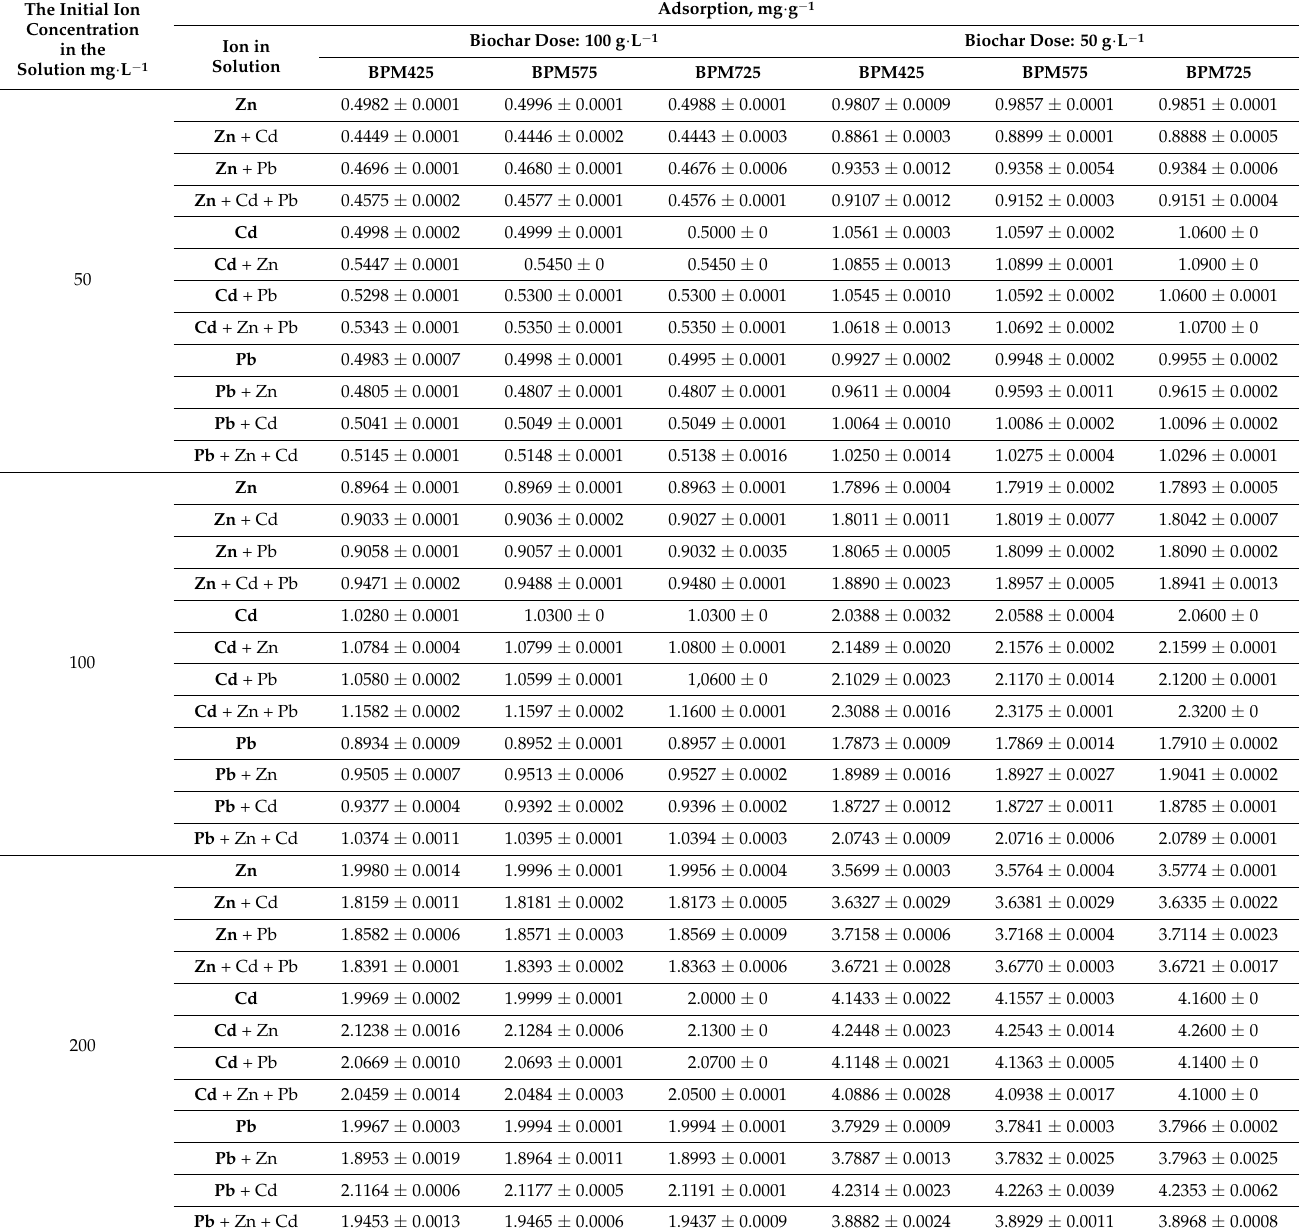
Table 14. Adsorption of metal ions in mono-, double- and triple-metal combinations for the investigated biochars. The Initial Ion Concentration in the Solution mg · L −